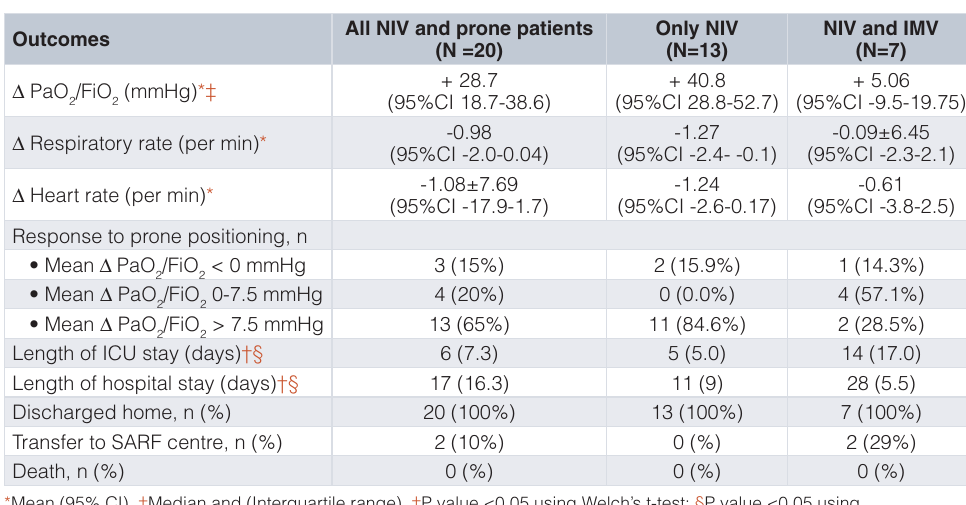
Table 3. Outcome variables.